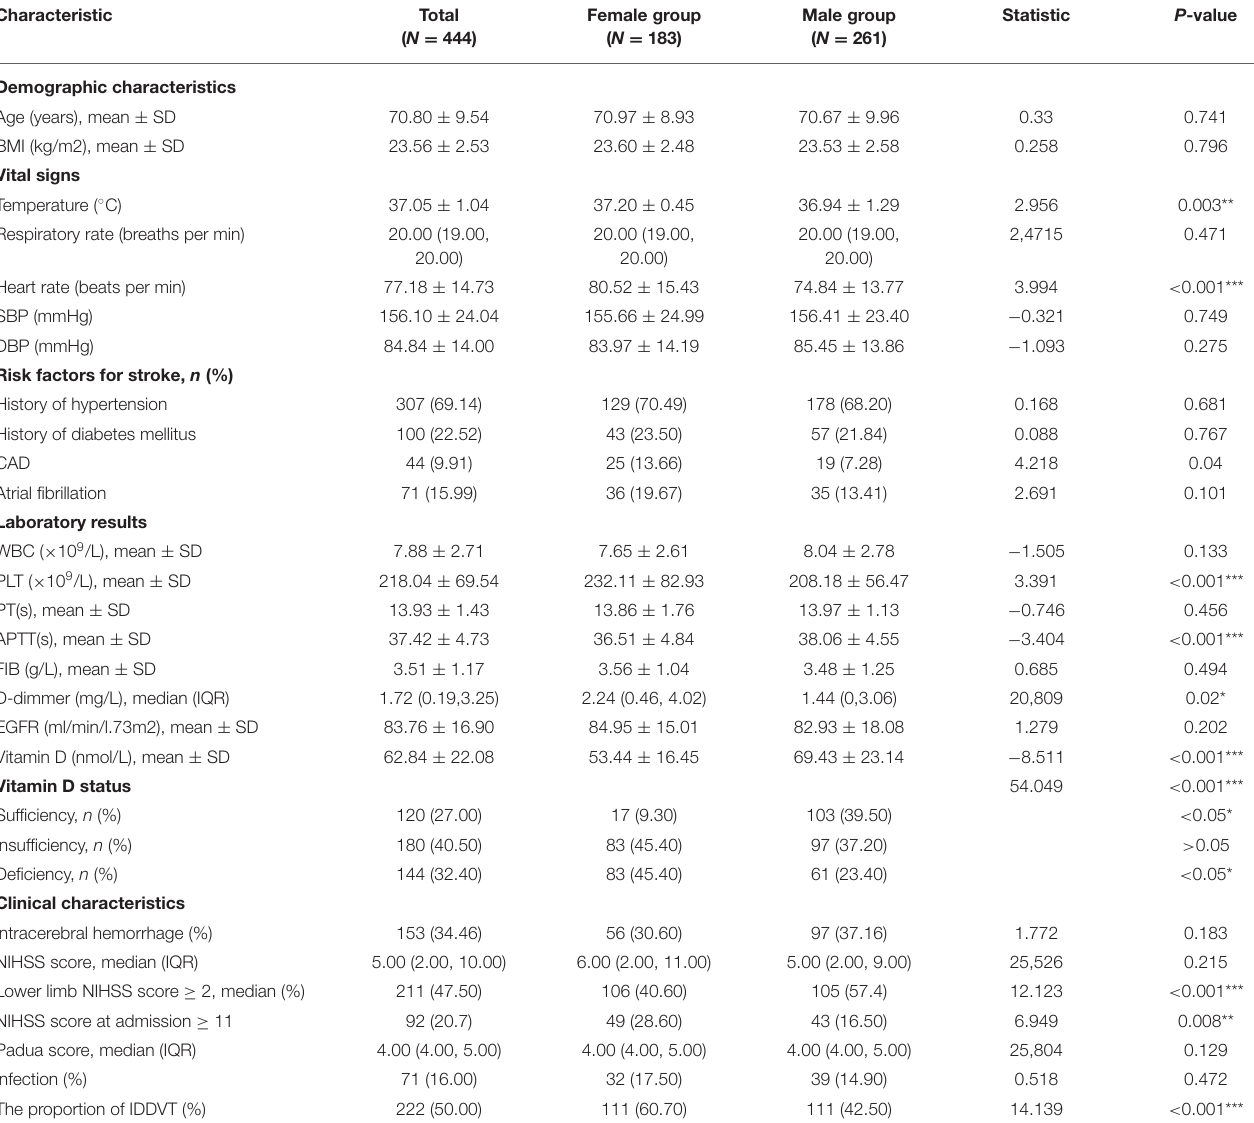
TABLE 2 | Characteristics of the patients categorized by gender. Characteristic Total